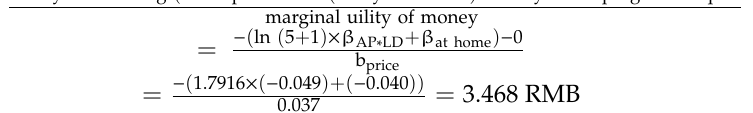
Lightly Polluted Areas